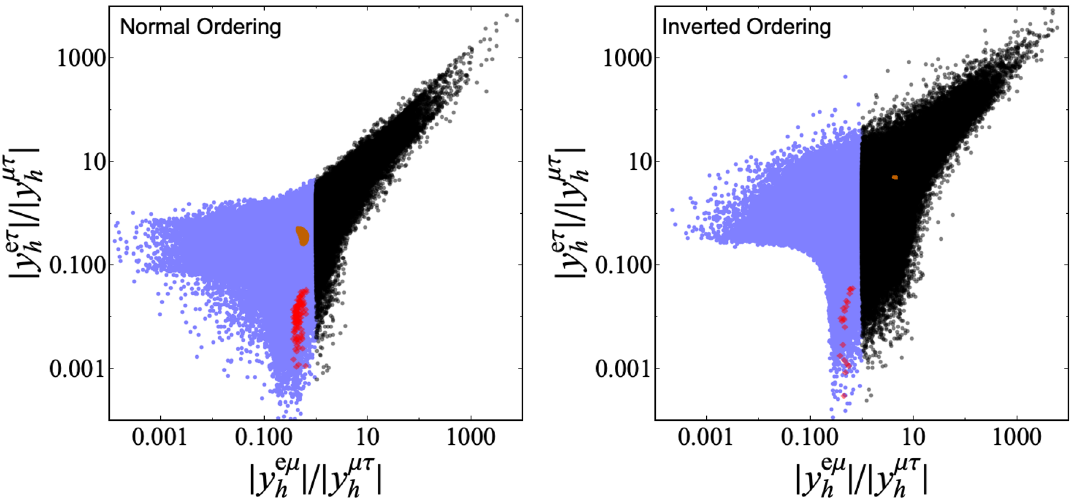
| / | y µτ | and | y eτ | / | y µτ | as obtained in the numerical scan. h h h h